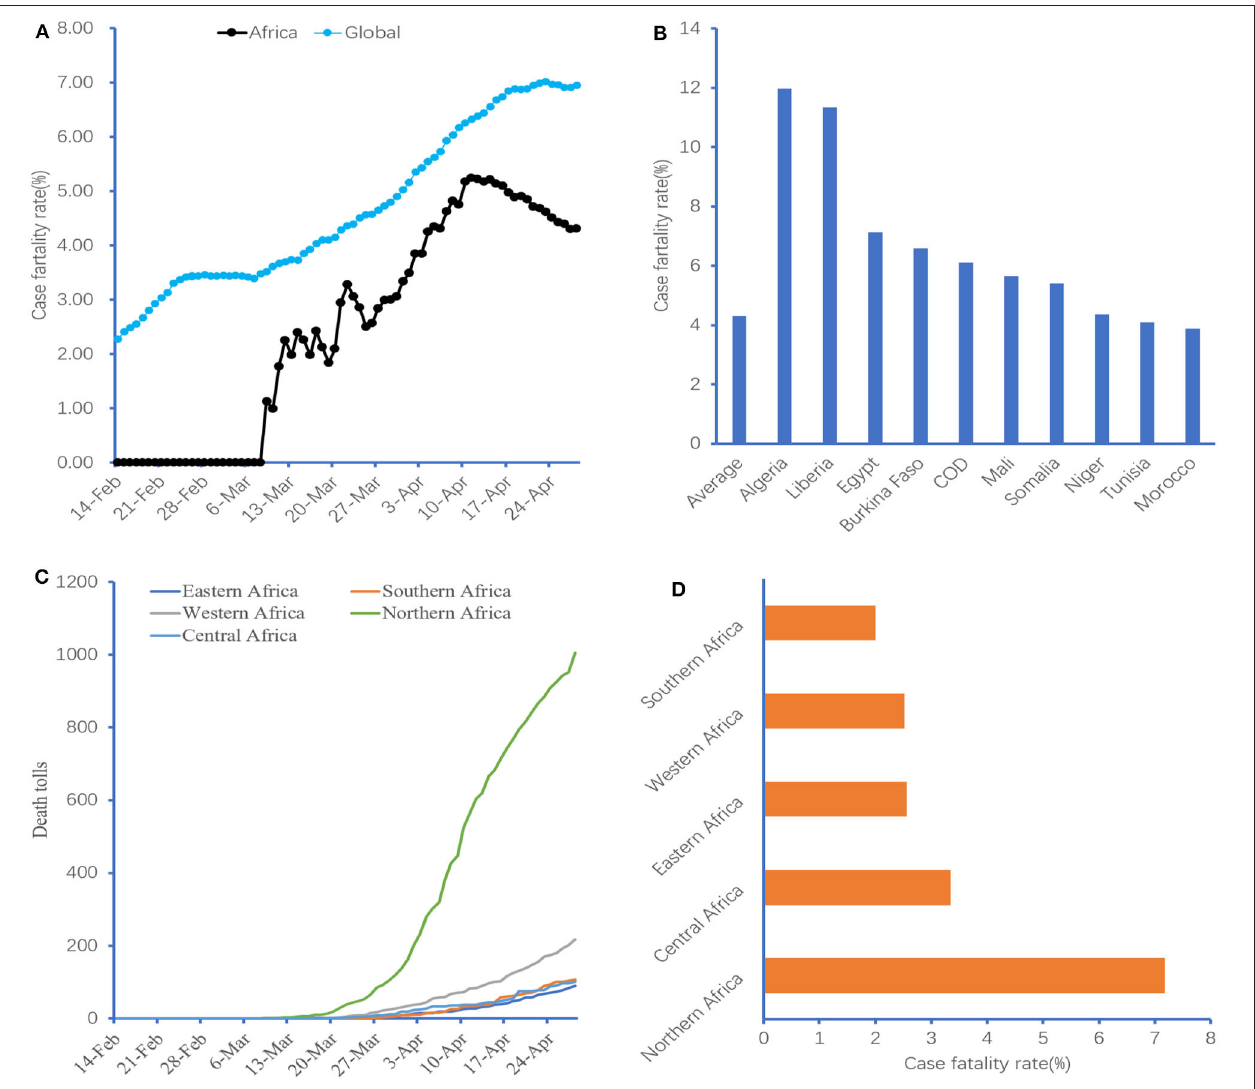
FIGURE 3 | Case fatality rate and region difference. (A) CFR of COVID-19 in Africa, (B) the top 10 African countries with COVID-19 CFR. COD, The Democratic Republic of the Congo; CFR, case fatality rate. (C,D) Comparison of COVID-19 CFR in different African regions. Three countries of Sahrawi Arab Democratic Republic (Northern Africa), Union of the Comoros (Eastern Africa), and Kingdom of Lesotho (Southern Africa) are not